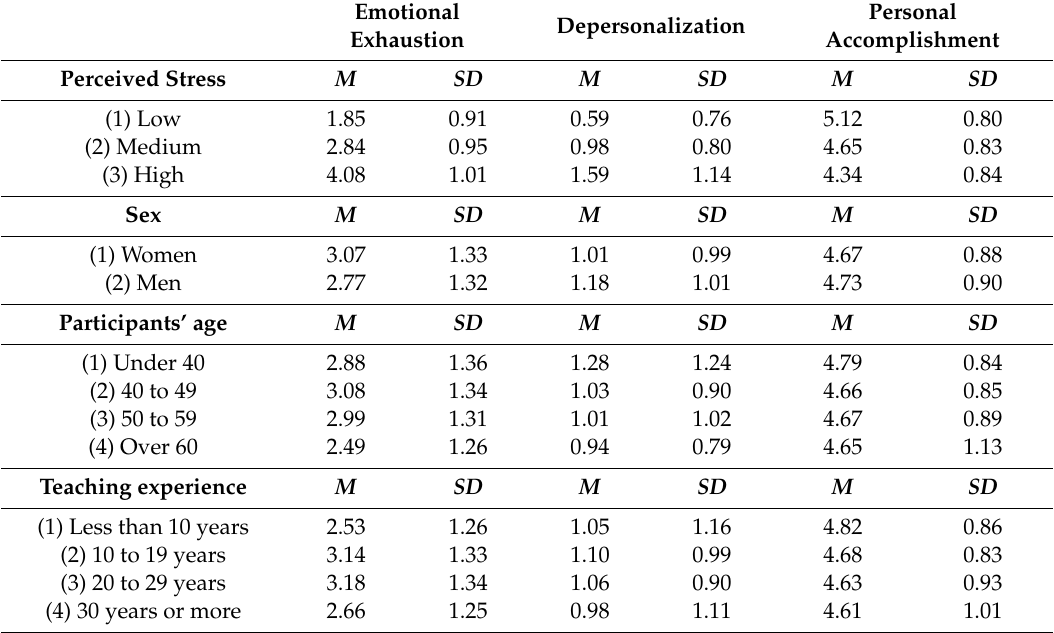
Table 3. Descriptive statistics in the three dimensions of burnout according to perceived stress, sex, age and years of service of the participants.